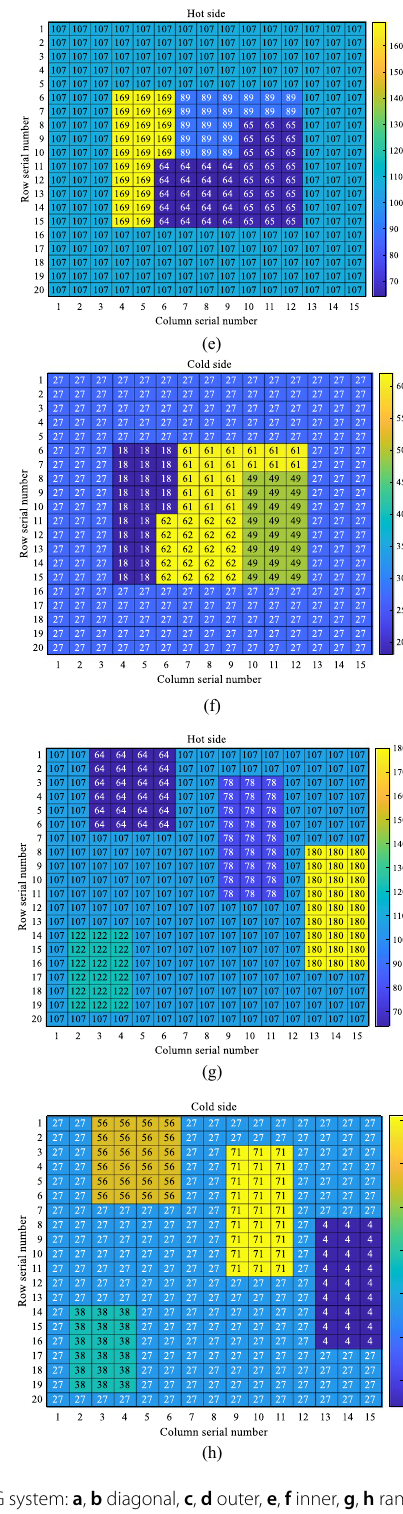
Fig. 10 Initial temperature distribution (°C) of four different scenarios for (20